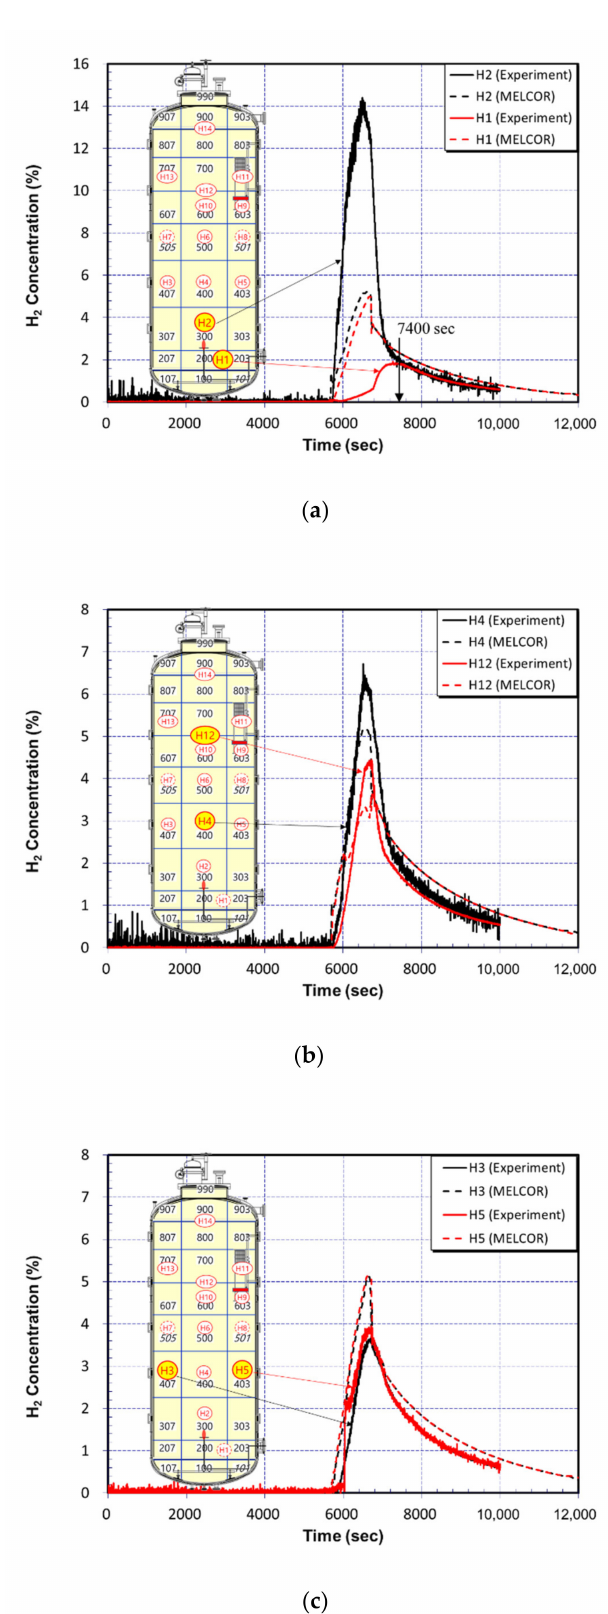
Figure 14. Comparison of H 2 concentration for SSP1 test: ( a ) At locations of H1 and H2; ( b ) At locations of H4 and H12; ( c ) At locations of H3 and